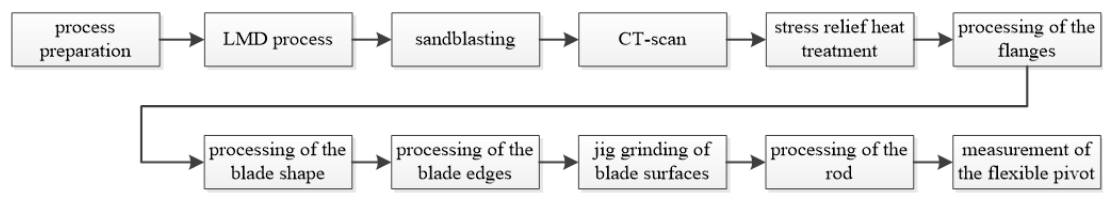
Figure 28. Manufacturing workflow.